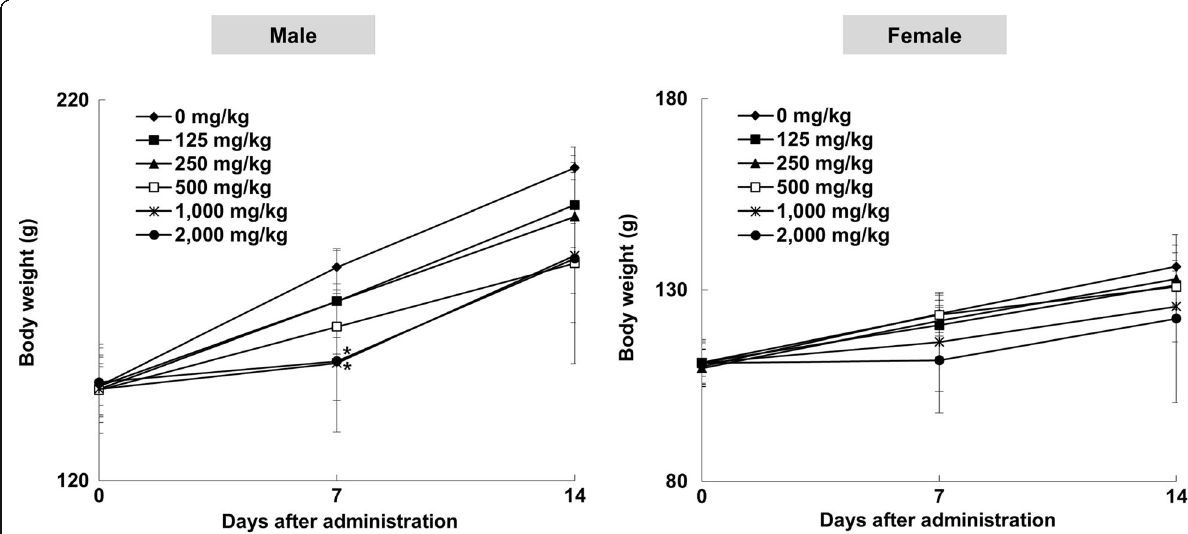
Fig. 2 Body weight values of male and female F344 rats orally administered with Tiglium seed extract in 14-day repeat-dose toxicity study. Data are expressed as means ± SD (n = 3 – 5/sex/group). *Significantly different from Control group ( p <